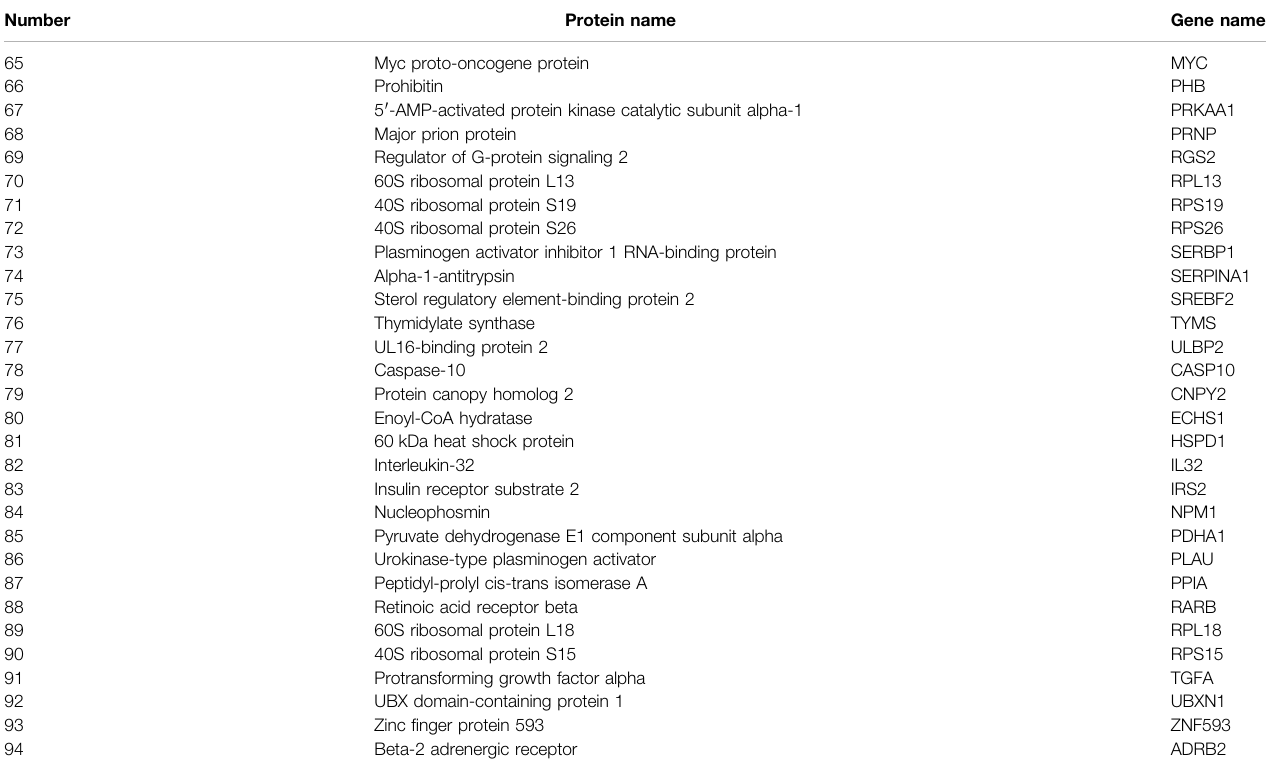
( Supplementay Table S1 ), and 343 genes related to human gastric cancer were identi fi ed from the DisGeNET database ( Supplementay Table S2 ). 94 overlapping genes between D. of fi cinale extract-associated genes and human gastric cancer- associated genes were obtained by the online tool Venny 2.1.0 software ( Table 2